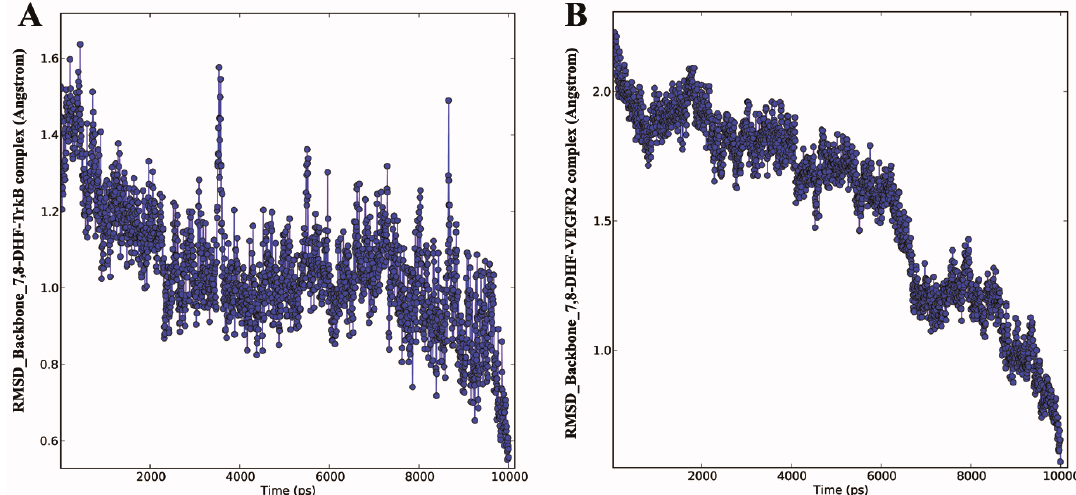
Figure 4. The MD simulation time vs. RMSD of the backbone atoms. ( A ) 7,8-DHF-TrkB protein complex; ( B ) 7,8-DHF-VEGFR2 protein complex.